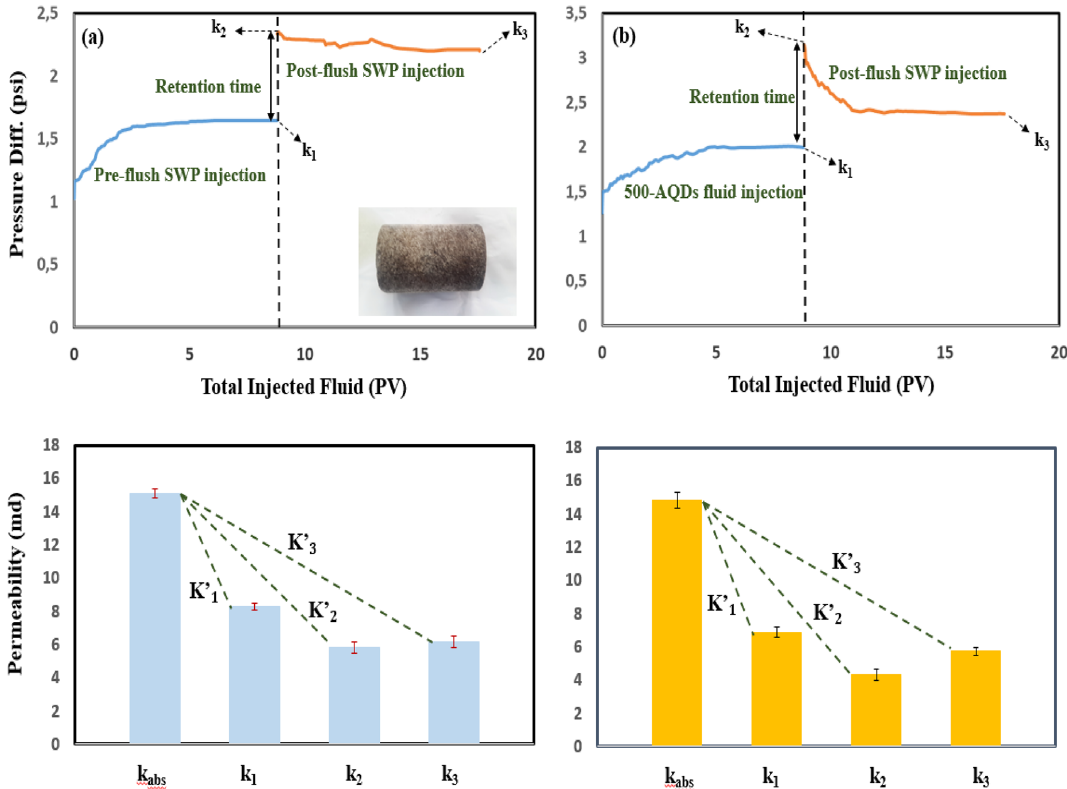
Figure 7. Differential pressure curves for fluid injection experiment in absence of oil for ( a ) core E’, SWP/ retention time/SWP ( b ) core E”, 500-PE-cit-AQDs nanofluid/retention time/SWP, retention time = 72